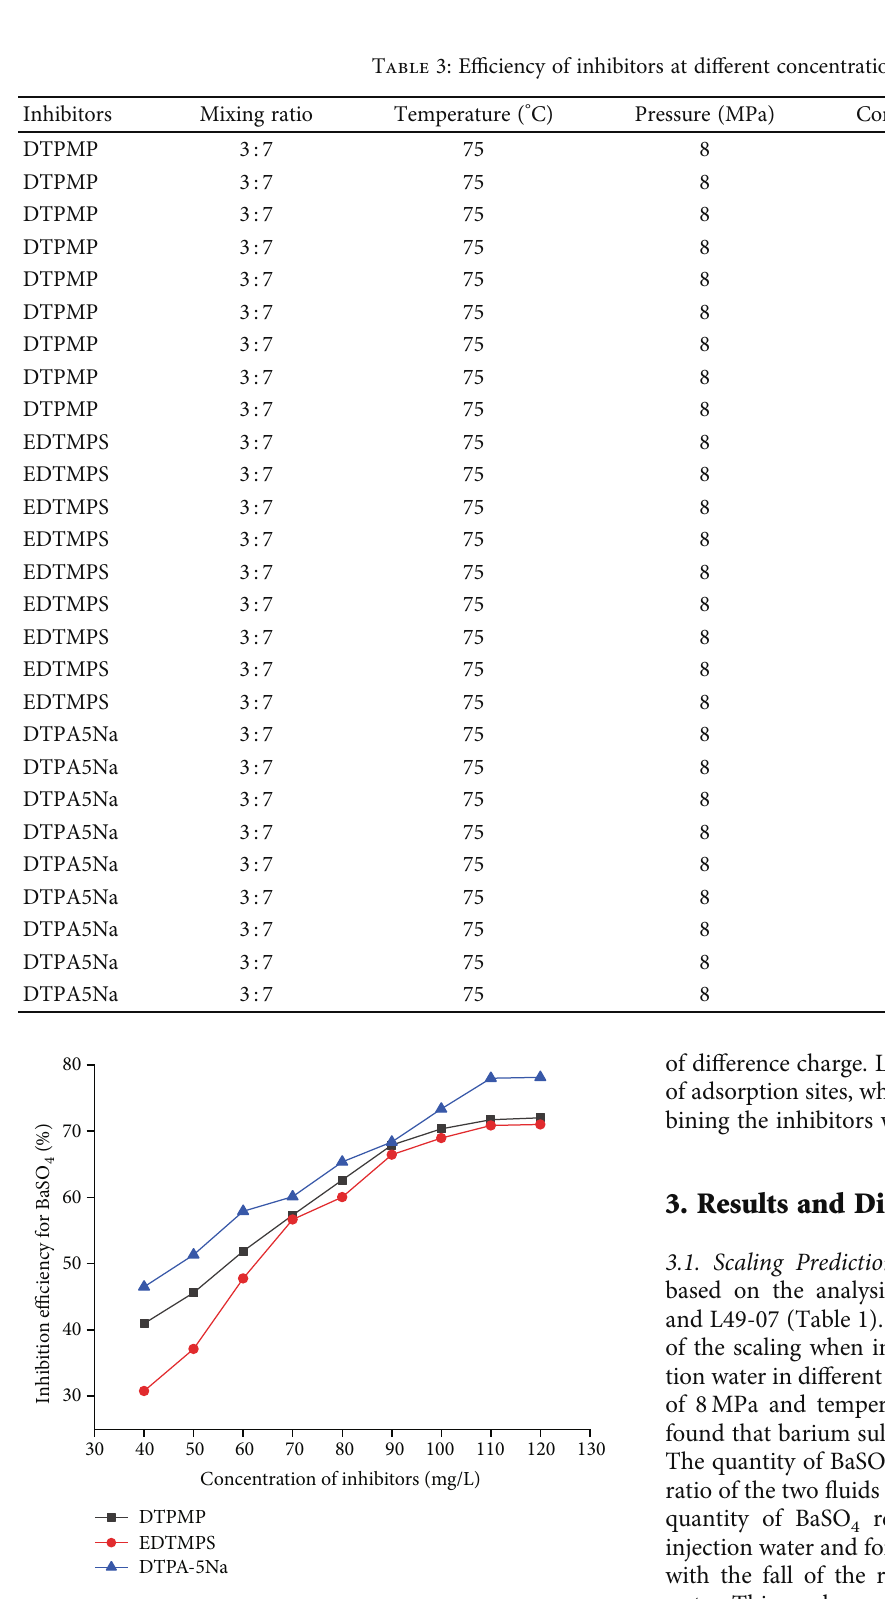
Figure 2: The antiscaling performance of several inhibitors for at di ff erent BaSO 4